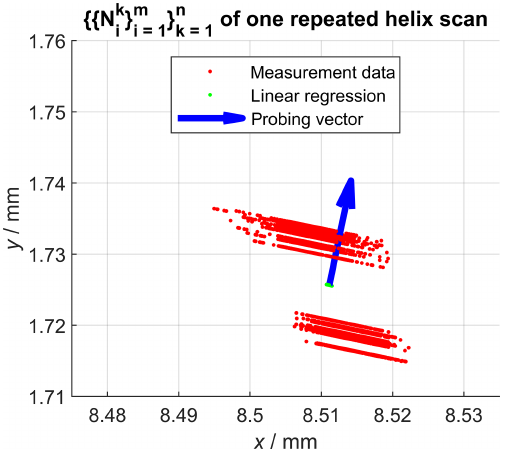
Figure 5. Projection of the calculated nominal geometry into the x – y plane. Measurement deviations perpendicular to the probing vector ( z component is zero) are not recorded.